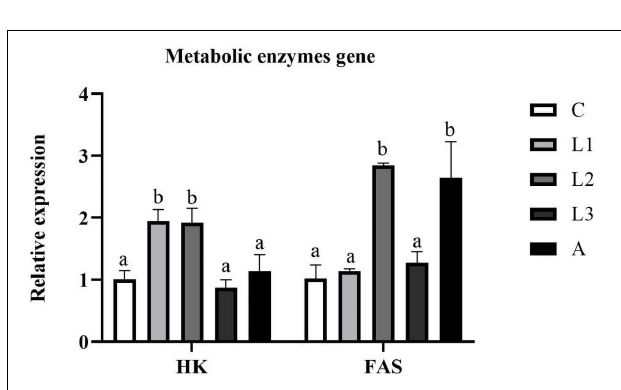
FIGURE 5 | Hepatopancreas RNA expression level of metabolic enzymes genes of L. vannamei fed diet supplementation with/without lutein or astaxanthin for 56